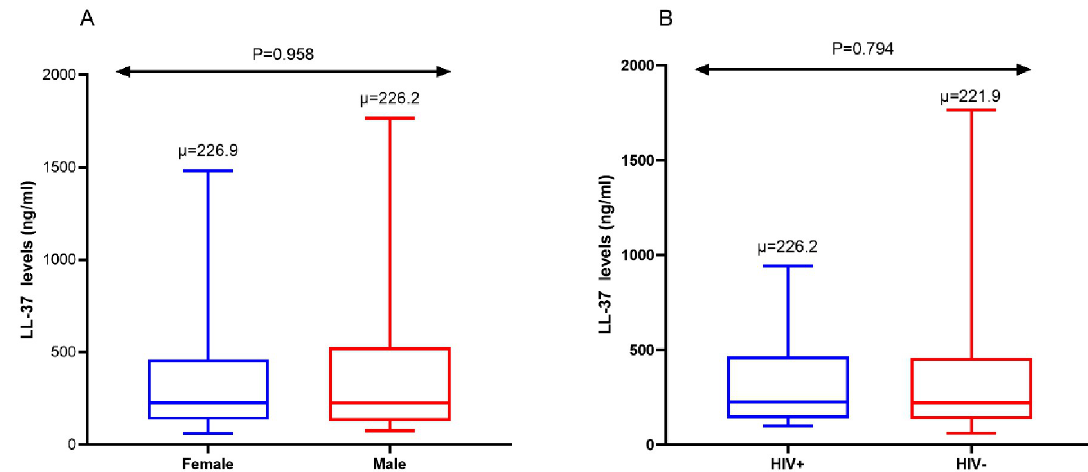
Fig 2. Overall median levels of LL-37 by gender and B. HIV infection status among all three groups combined. Mann-Whitney U tests were performed. The upper and lower end of the box represents the 75 th and 25 th percentile.